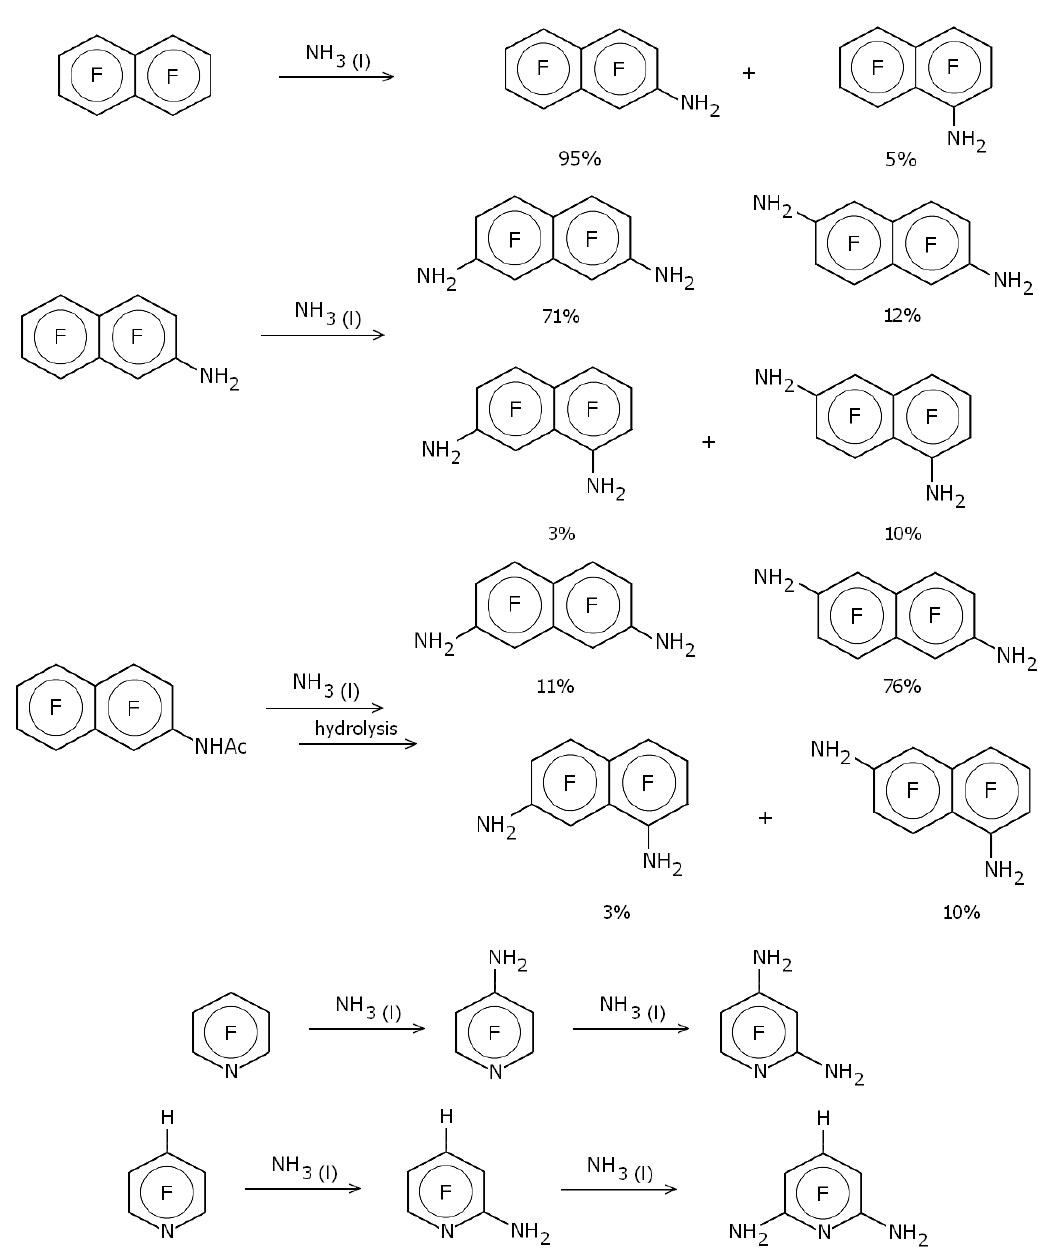
Figure 1. Amination reactions in liquid